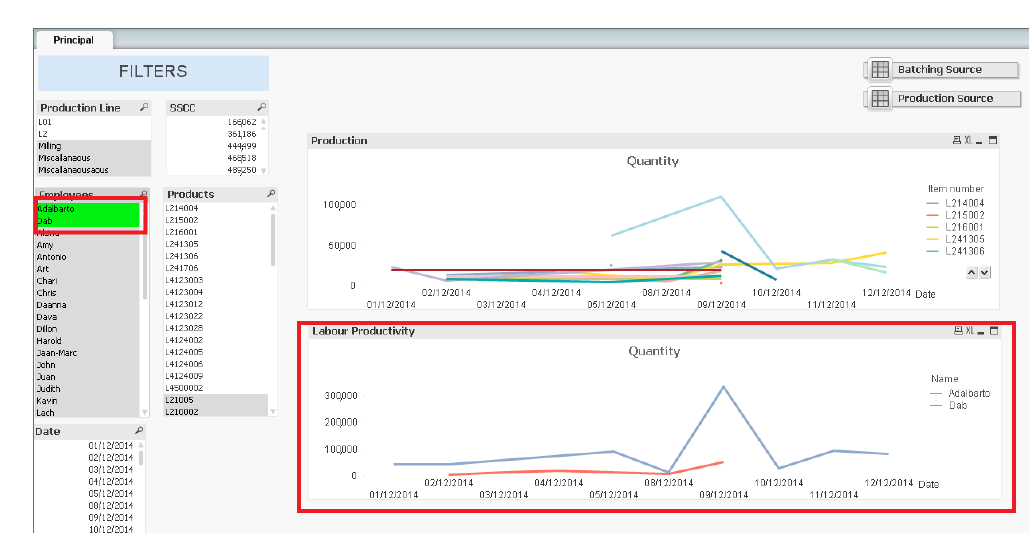
Figure 5. Comparative graph showing the labor productivity.